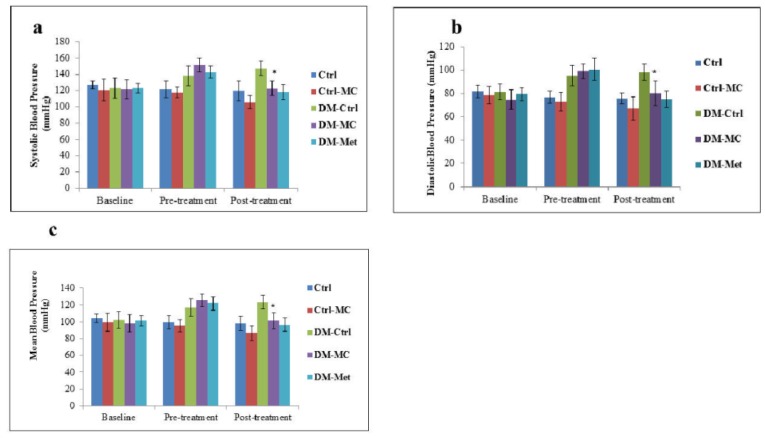
Effect of MC fruit extract on the blood pressure of Sprague-Dawley rats * Indicates a significant decrease (P < 0.05) in a(SBP), b(DBP) and c(MBP) mmHg of the DM-MC group compared to the DM-Ctrl group.